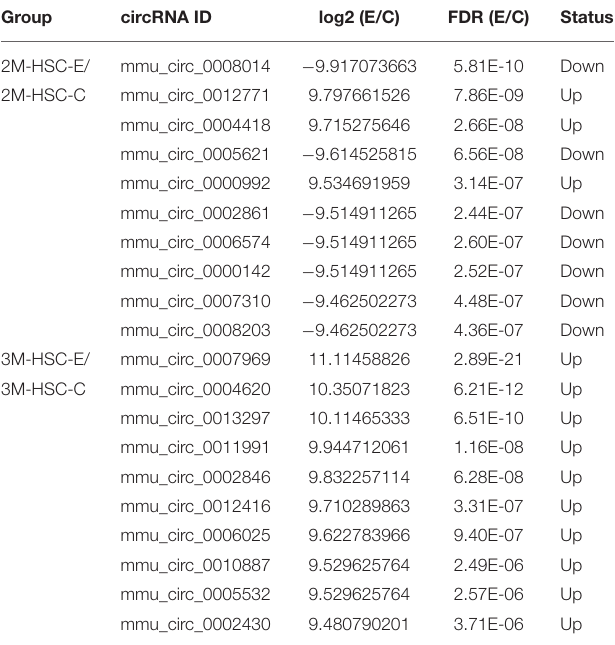
TABLE 3 | Top 10 dysregulated circRNAs in hepatic stellate cells of murine liver after E. multilocularis infection. Group circRNA ID